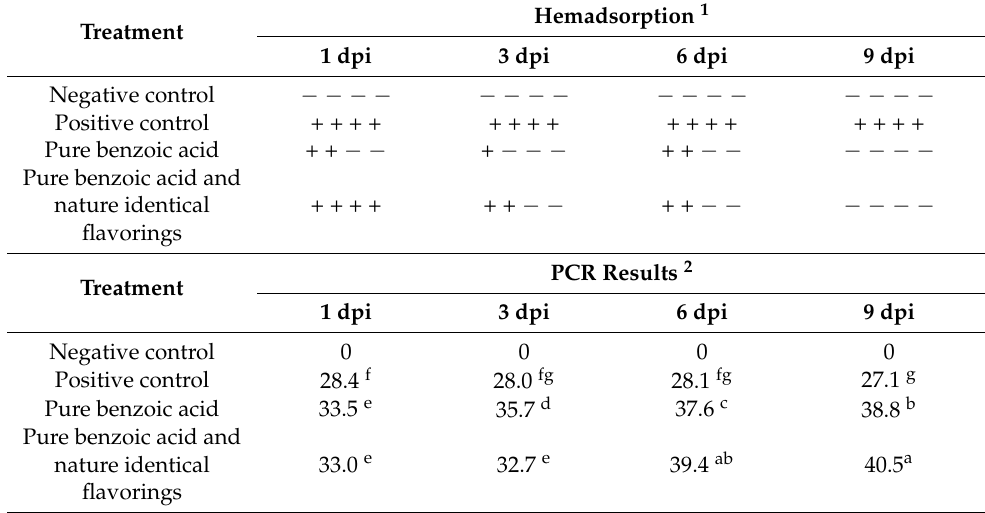
Table 3. Effect of pure benzoic acid and the combination of pure benzoic acid and nature identical flavorings on hemadsorption and detection of ASF virus by real time-PCR at different days post inoculation (dpi) in phosphate-buffered saline.